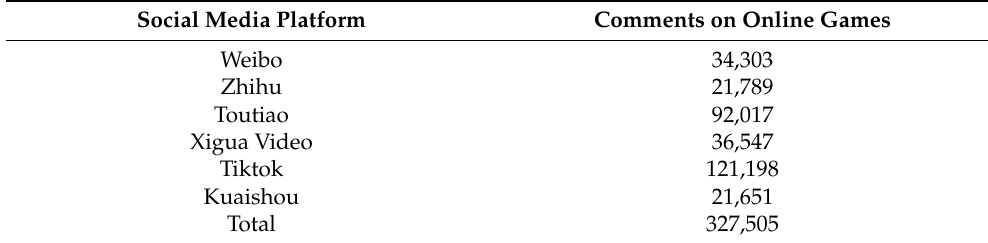
Table 1. Data sources and corpus